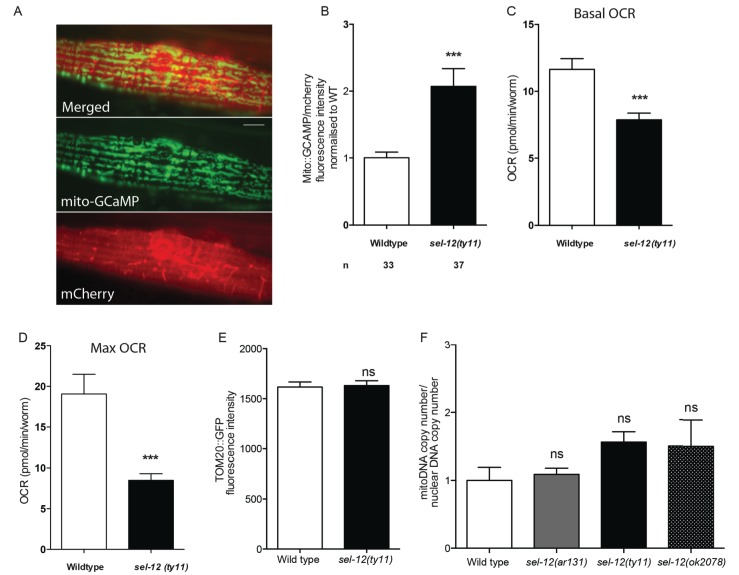
Mitochondrial Ca2+levels are higher in sel-12 mutants.(A) Representative image of mito-GCaMP6 and mCherry expression (takEx347). Scale bar represents 10 μm. (B) Quantification of mitochondrial Ca2+ using animals expressing mito::GCaMP6 and mCherry in their mechanosensory neurons (takEx415). (C) Basal and (D) maximal respiration rates of wild type and sel-12 mutant animals at day 8 of adulthood. (E) Mitochondrial fluorescence intensity measured in wild type and sel-12(ty11) animals expressing TOM20::GFP (zcIs14) (F). Quantification of mitochondrial DNA copy number normalized to nuclear DNA copy number in wild type and sel-12(ar131), sel-12(ty11) and sel-12(ok2078) animals. n = number of animals analyzed per genotype. Data are displayed as mean ± SEM, and all comparisons have been made to wild type animals. ns p>0.05, ***p<0.0001 (Two-tailed T-test for B-E, one way ANOVA with Tukey test for F).10.7554/eLife.33052.020Figure 1—figure supplement 1—source data 1.Raw data for Figure 1—figure supplement 1.